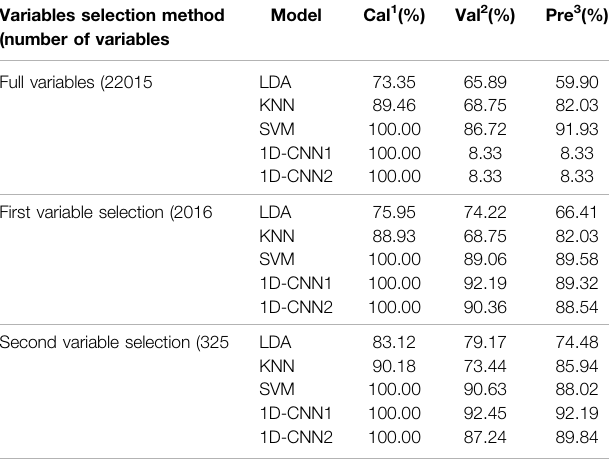
TABLE 1 | The results of discriminant models based on underground parts of G. rigescens Franch using full spectra and selected variables. Variables selection method (number of variables